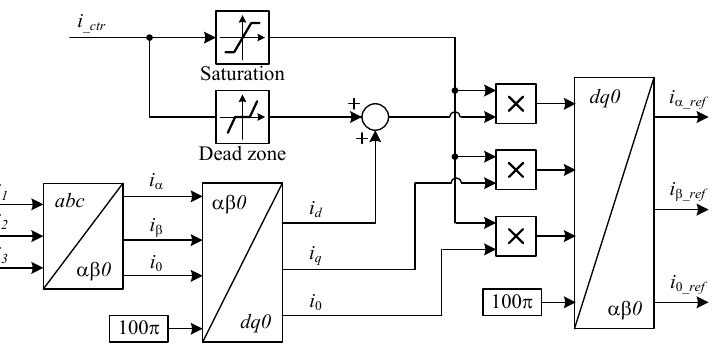
Figure 7. Scheme for the generation of the inverter current references for the compensation of reactive power and harmonics.